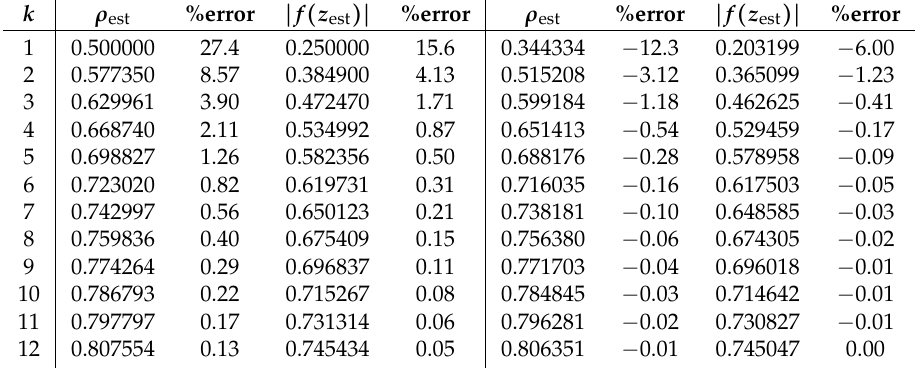
Table 2. Quadratic (left set) and cubic (right set) estimated values of ρ S and corresponding separatrix level set value, for the first separatrix. The percent error is given relative to the “exact” values